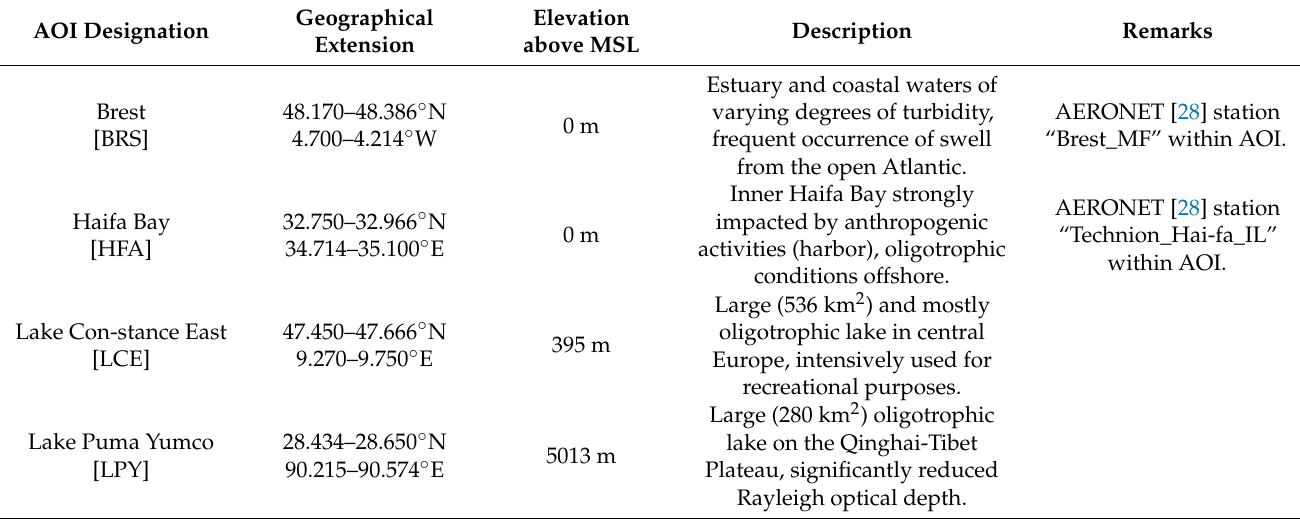
Table 2. Areas of interest (AOI) used in the development of the Glint Removal through